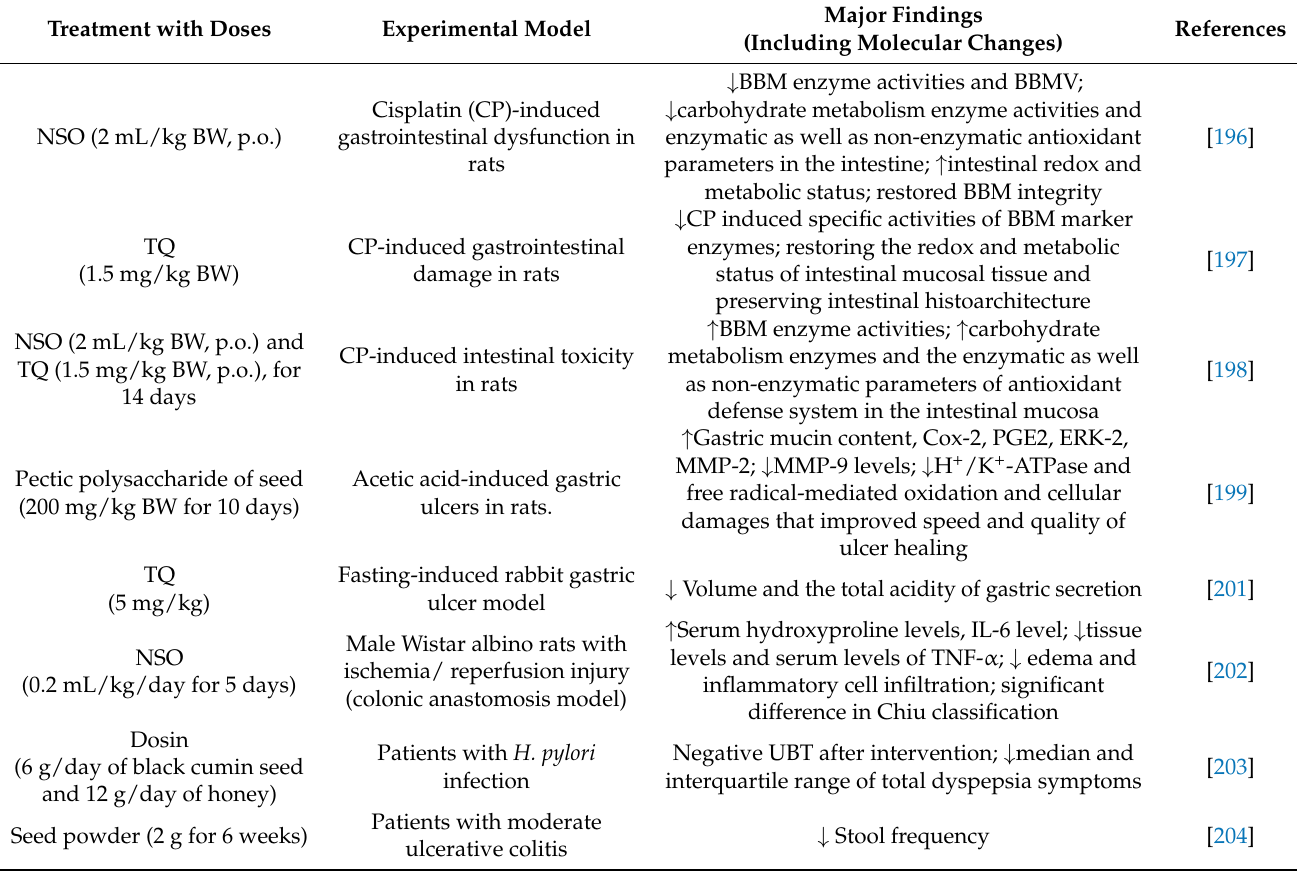
Table 8. Comprehensive summary on the gastroprotective effects of black